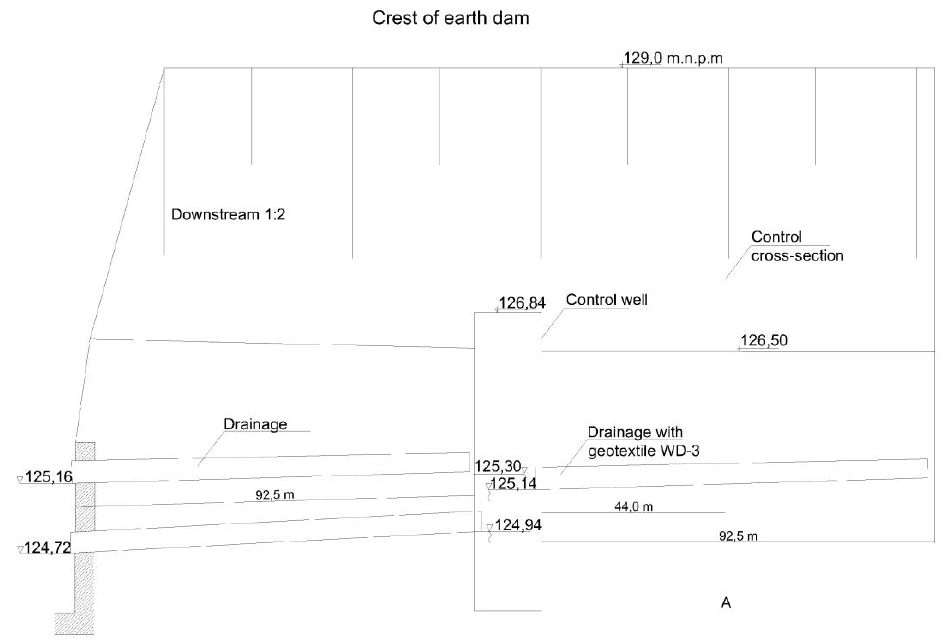
Figure 4. Schematic diagram of downstream